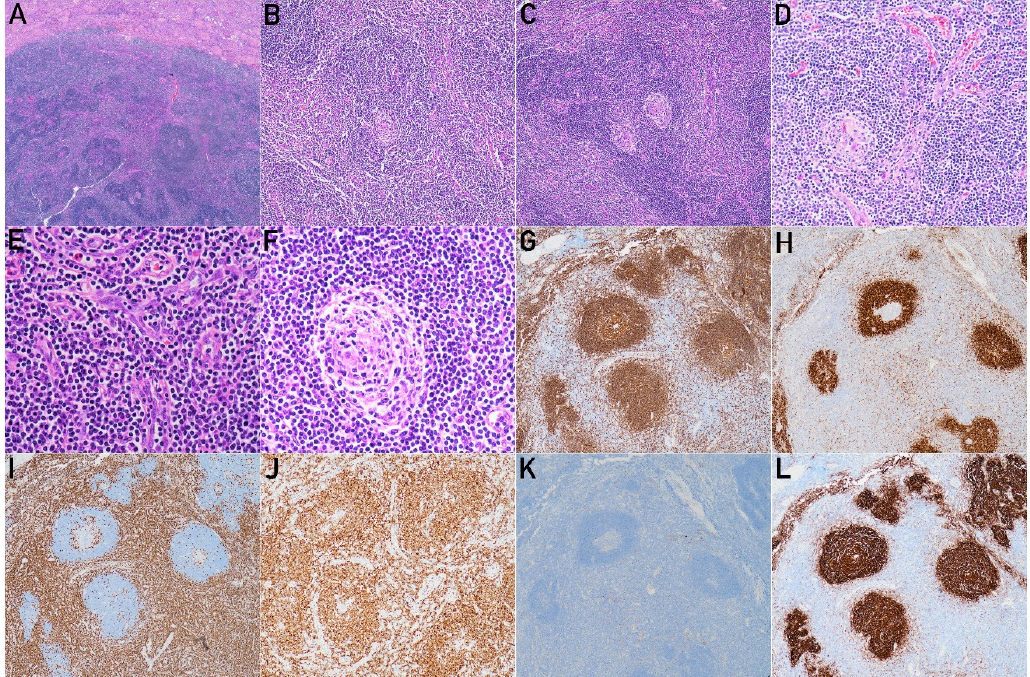
Figure 4. Pathological features of this case. ( A ) A well-delineated lesion composed of hyperplastic lymphoid follicles distinct from underlying renal parenchyma (H&E stain, ×20). ( B , F ) Thickened mantle zone and atrophic germinal centers, forming an “onion skin-like” structure (H&E stain, ×100 and ×400, respectively). ( C ) Twinning feature (H&E stain, ×100). ( D ) The follicle is penetrated by hyalinized capillaries (H&E stain, ×200). ( E ) The extensive vascular proliferation of high endothelial venules with perivascular hyalinization in the interfollicular regions (H&E stain, ×400). ( G ) Im- munohistochemistry of CD20 highlights the mantle zones and germinal centers (×100). ( H ) Immuno- histochemistry of IgD highlights the mantle zone (×100). ( I ) Immunohistochemistry of CD3 high- lights the T lymphocytes (×100). ( J ) Immunohistochemistry of Bcl-2 is expressed in T cells and man- tle cells but not germinal centers (×100). ( K ) Immunohistochemistry of cyclin D1 shows negative staining (×100). ( L ) Immunohistochemistry of CD21 highlights the proliferation of follicular den- dritic cells (×100).